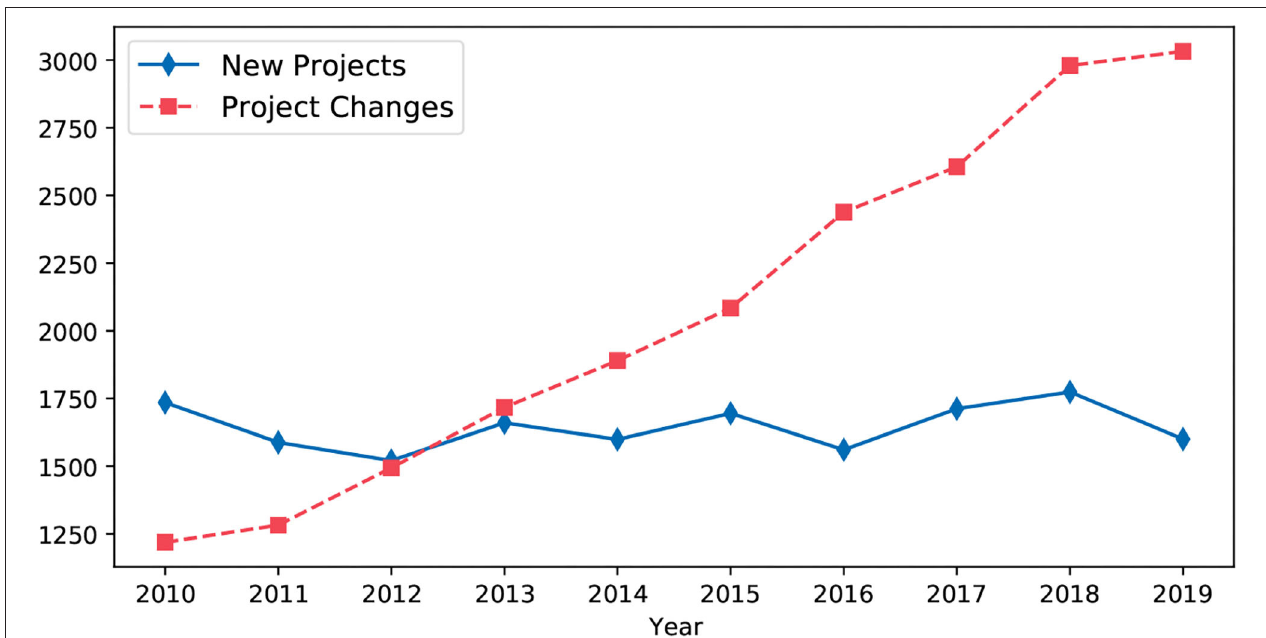
FIGURE 1 | Different types of applications processed annually at Norwegian ethics committee (REK,